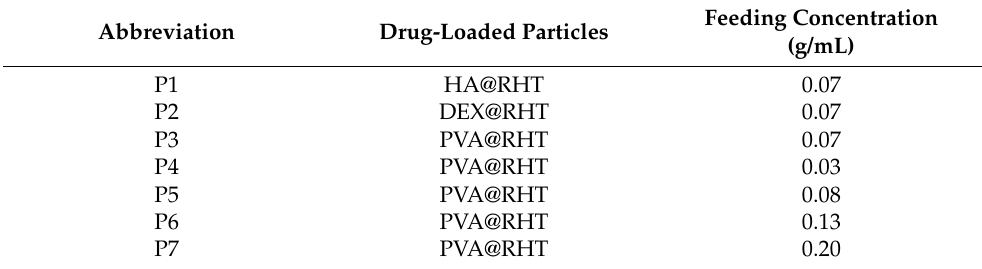
Table 3. Formulation compositions and feeding concentrations of drug particles.